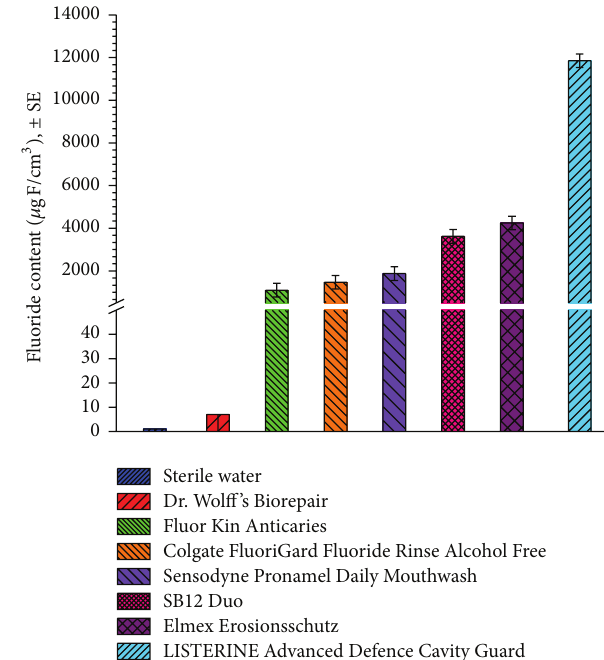
Figure 2: Results of the mean enamel fluoride uptake study ( 𝑛 = 12